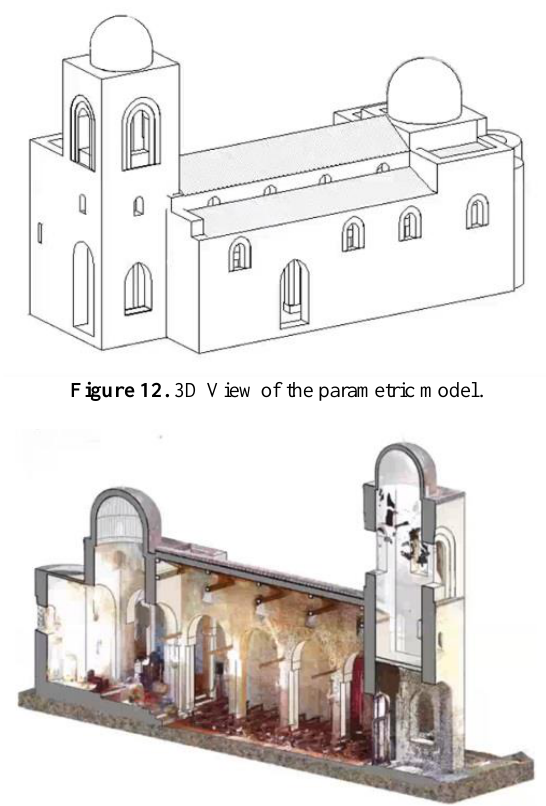
Figure 13. Axonometric sections of the parametric model with the point